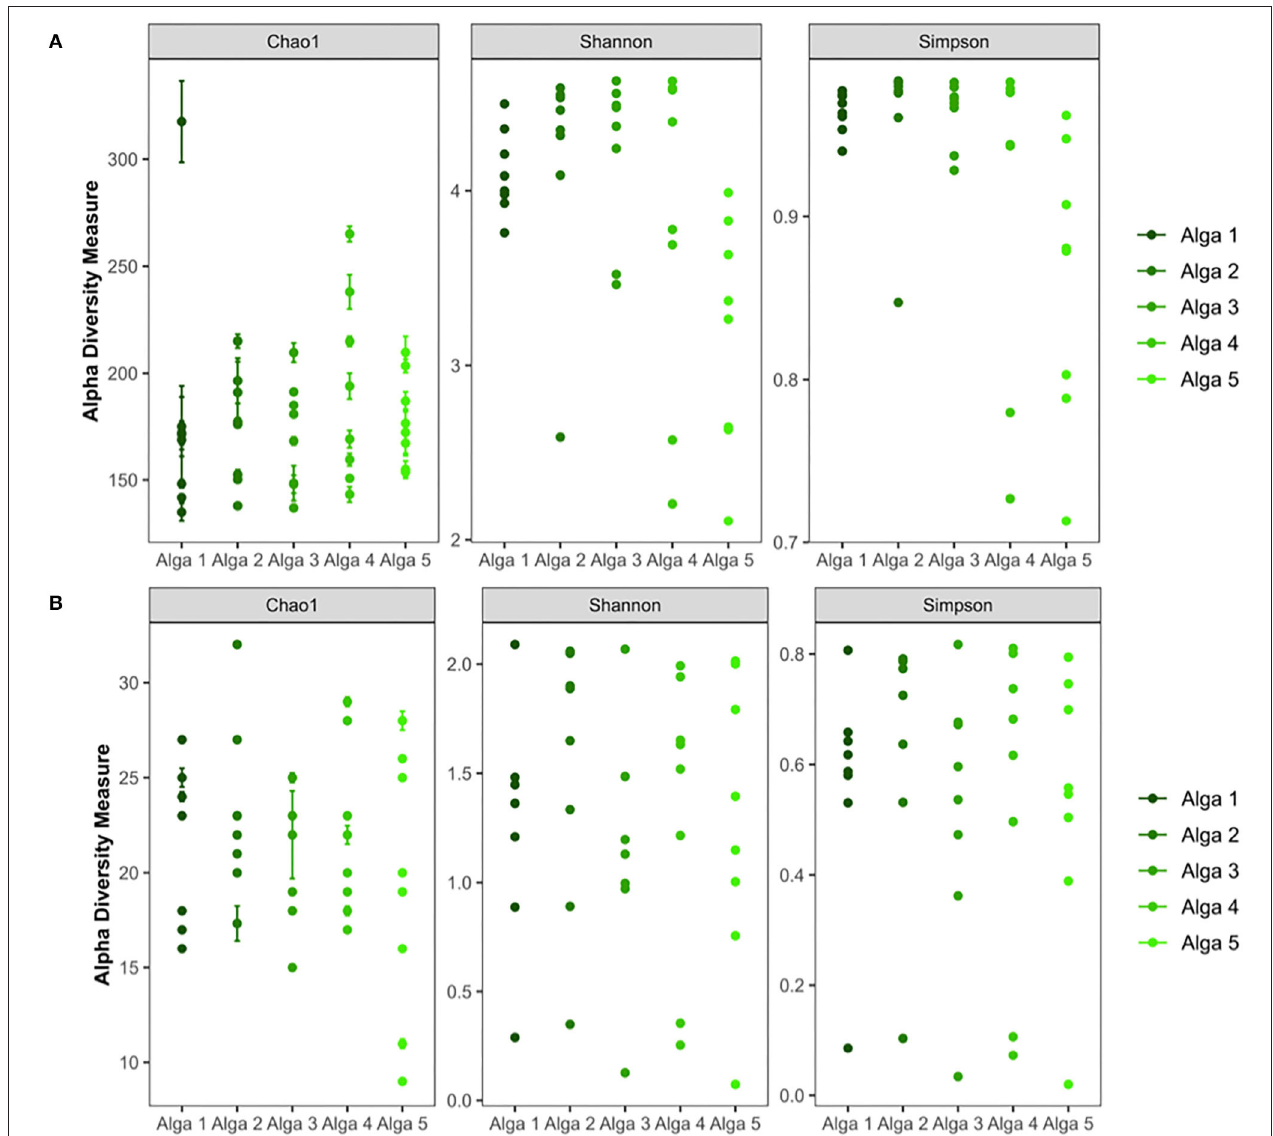
FIGURE 3 | Alpha-diversity analysis of bacterial (A) and fungal (B) communities of the Saccharina latissima